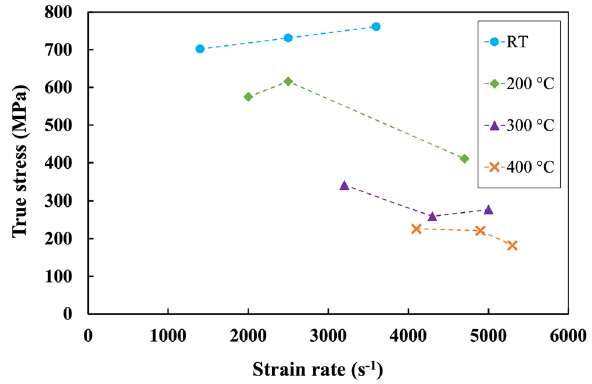
Fig. 5 Variation of flow stress for AA7075-T651 at a true strain of 0.1 as a function of strain rate